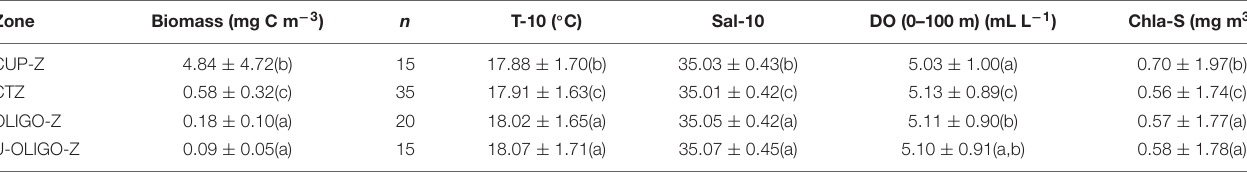
TABLE 2 | Mesozooplankton biomass (mean ± SD) and hydrographic variables in the four study regions. Zone